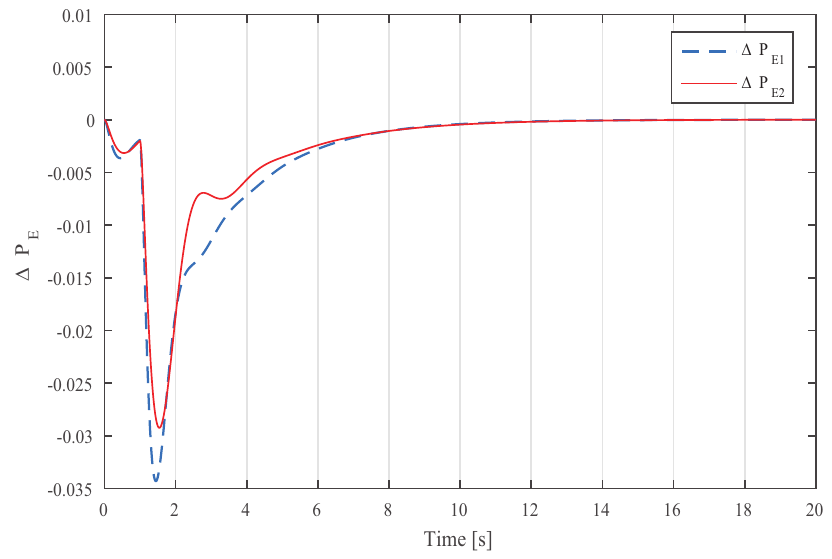
Figure 8. EVs’s responding curves of V2G system subjected to